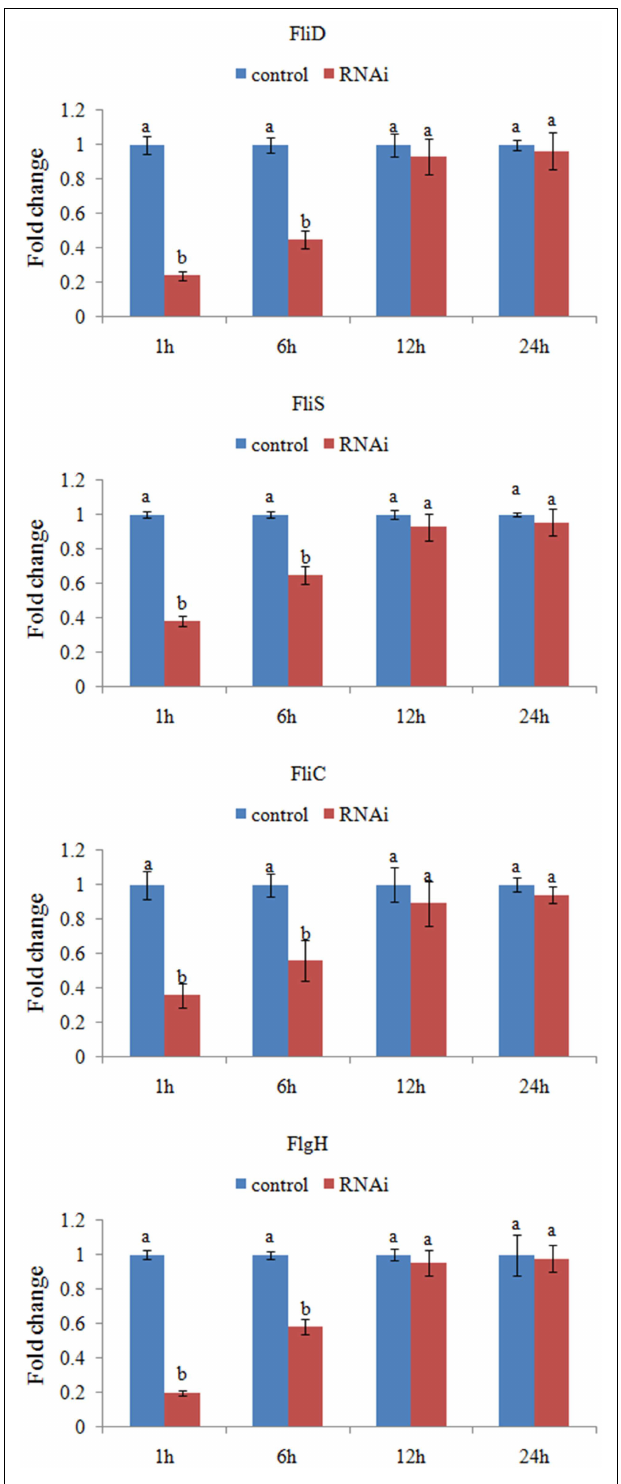
FIGURE 2 | QPCR analysis of the expression of FliD , FliC , FlgH , and FliS after transient gene silencing at 1, 6, 12, and 24h in comparison to the control. The data are presented as the means ± S.D. ( n = 6 ).The means of the treatments not sharing a common letter are significantly different at P < 0 . 05 .